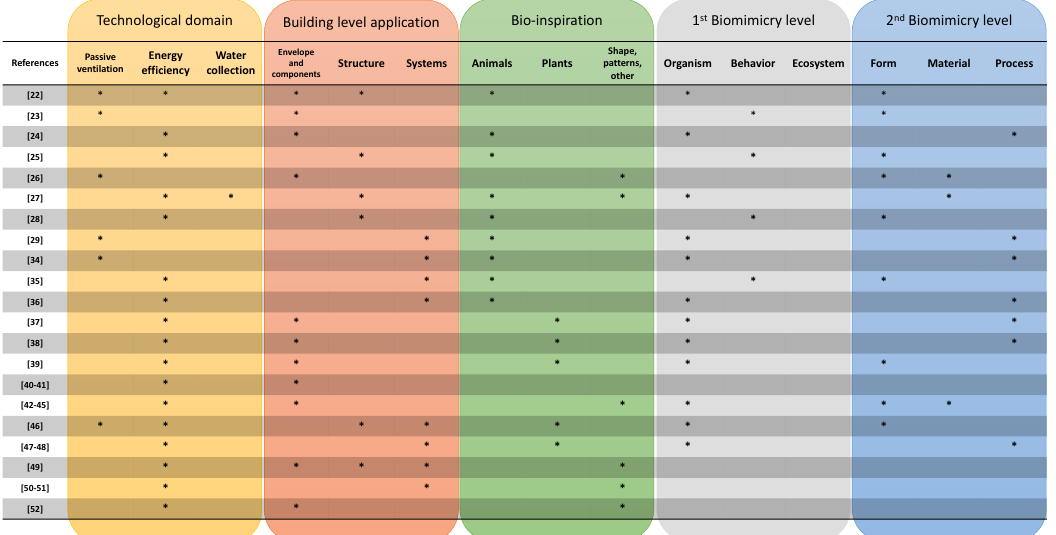
Figure 4. Summary of biomimicry strategies for building applications (asterisks (*) represents